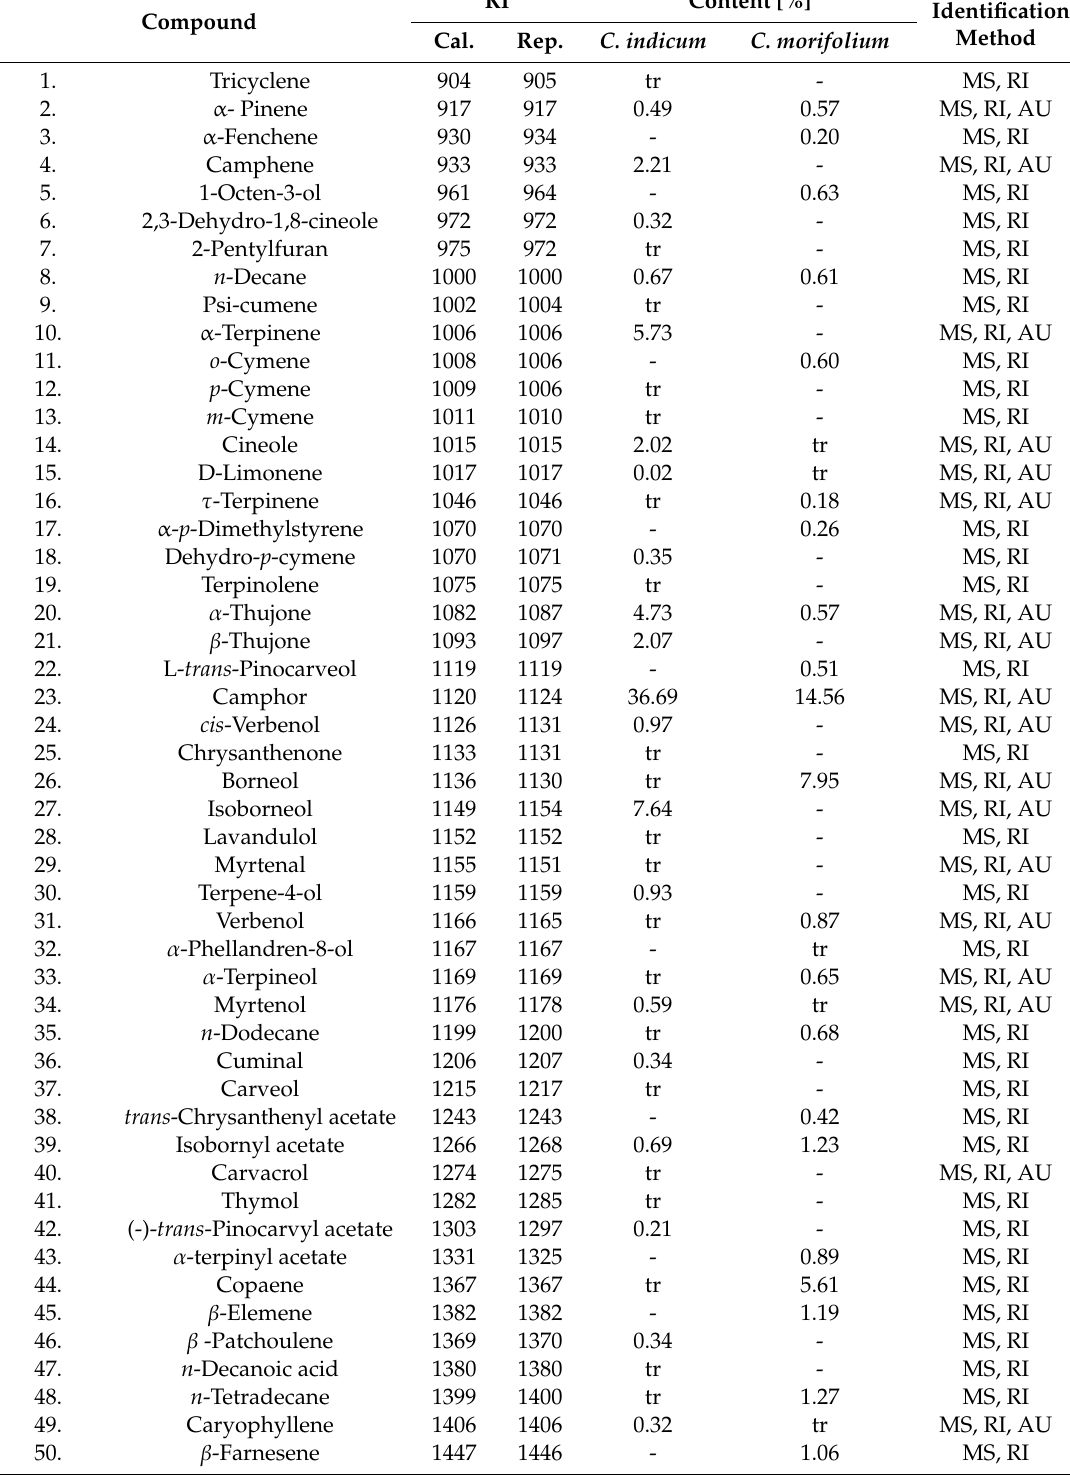
Table 1. Volatile oil compositions of C. indicum and C. morifolium flower